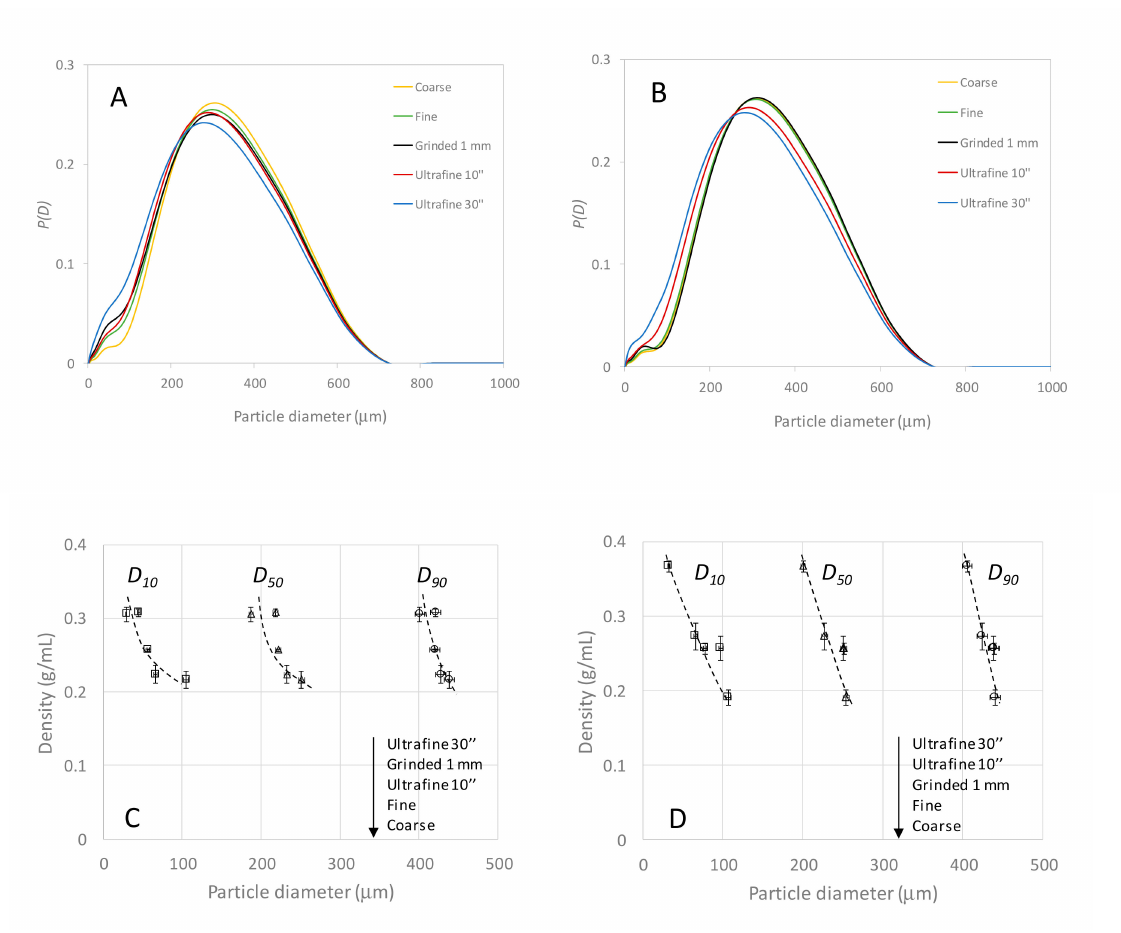
Figure 2. Relative size distributions of the raw and ground CA ( A ) and BC ( B ) plant materials obtained by laser granulometry in dry mode and variation of the density of CA ( C ) and BC ( D ) plant materials as a function of the particle diameter. D 10 ( (cid:3) ), D 50 ( ∆ ), and D 90 ( ) with D x being the tenth decile of (cid:35) the distribution. See Section 2.2 for more details on the experimental conditions. Lot number for CA: 559980. Lot number for BC: 55870. Table 3. Extraction yield, TFC, TPC, and OPC values in CA and BC extracts (‘fine’ ground) issued from infusion at 10 min extraction time using easy-to-use infusion extraction (2.5 g of plant material and 250 mL boiling water were introduced in Bodum ® French press recipient, see Section 2.8). Stirring was realized by manually rotating the recipient at the beginning of the infusion and 10 min later before filtration. a : in mg equation. GA / g dry plant, ± 1 SD ( n = 3 repetitions). b : in mg equation Q / g dry plant, ± 1 SD ( n = 3 repetitions). c : in mg equation CY / g dry plant, ± 1 SD ( n = 3 repetitions). Nature of the Plant Lot